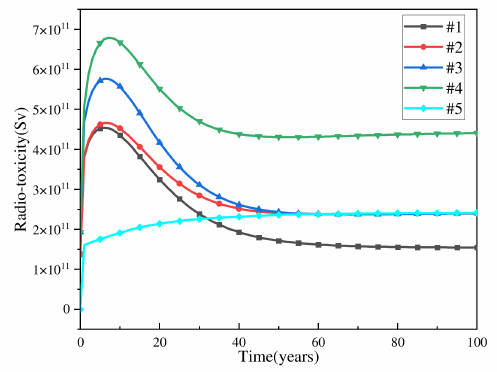
Figure 12. Evolution of